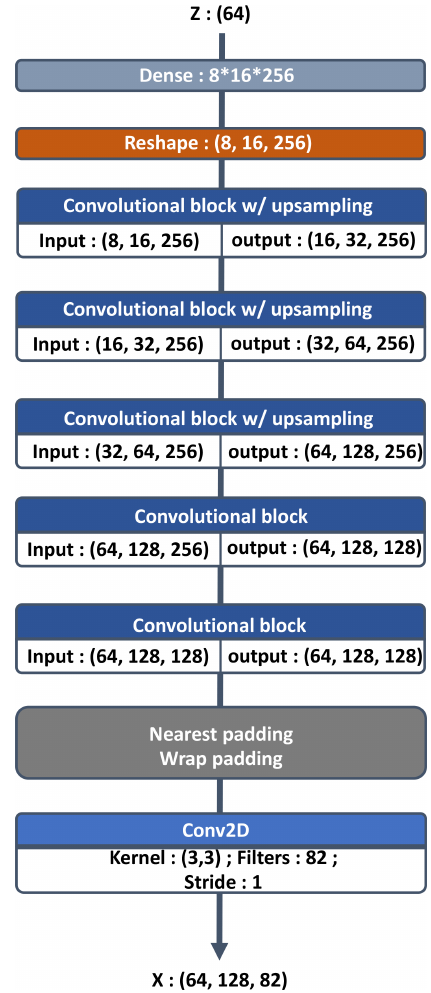
Figure 4. Generator